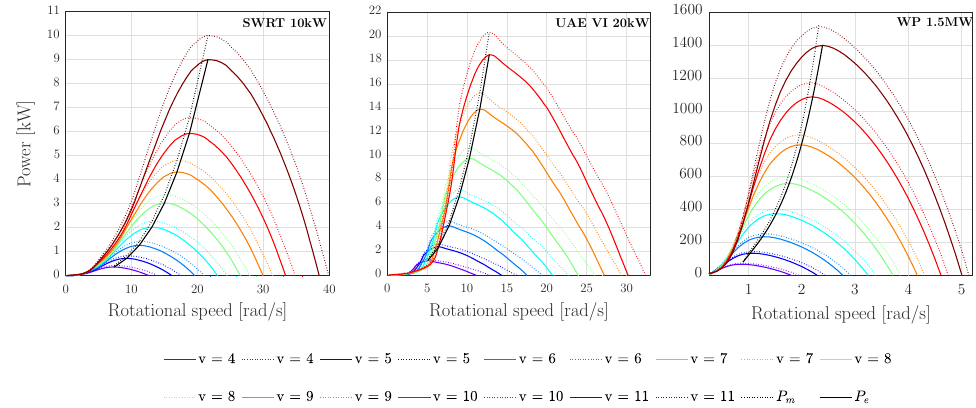
Figure 4. Electrical Maximum Power Point Tracking (MPPT) versus mechanical MPPT for SWRT, UAE, and WP wind